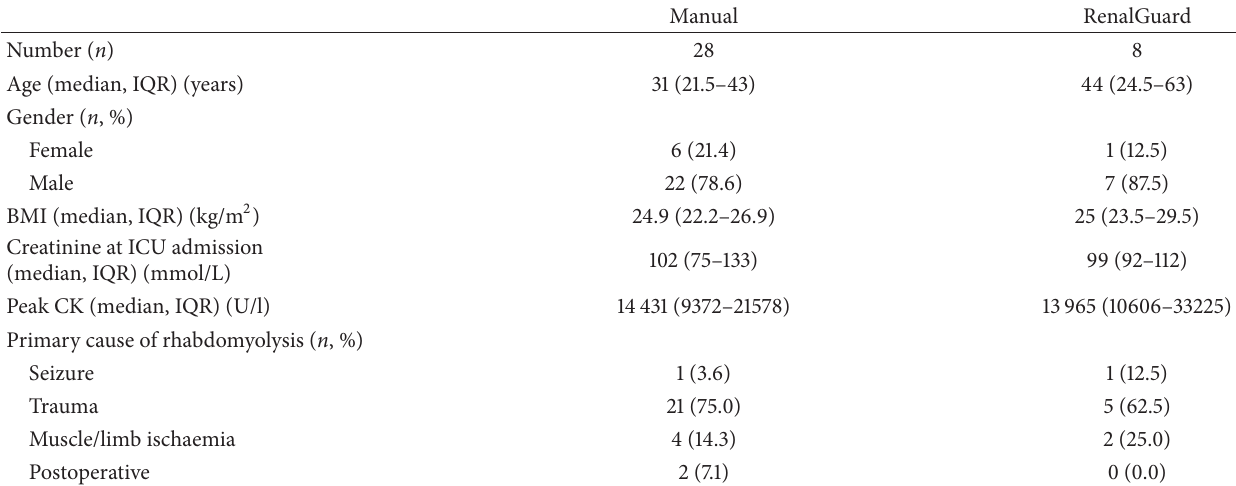
Table 1: Baseline Characteristics (median, interquartile range) and number (percentage); ICU, Intensive Care Unit, IQR, interquartile range; CK, Creatine Phosphokinase; U/l, international units per